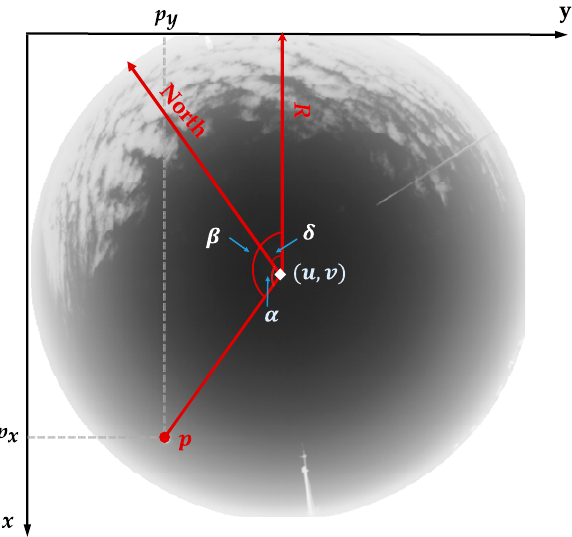
Figure 4. Illustration of the rotation angle with respect to the north for an infrared all-sky image.